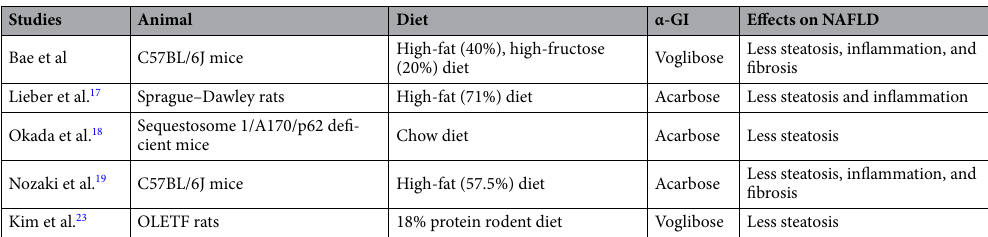
Table 2. Studies on the effects of α-glucosidase inhibitors in NAFLD animal models. α-GI, α-glucosidase inhibitor; NAFLD, non-alcoholic fatty liver disease; OLETF rats, The Otsuka Long ‐ Evans Tokushima fatty